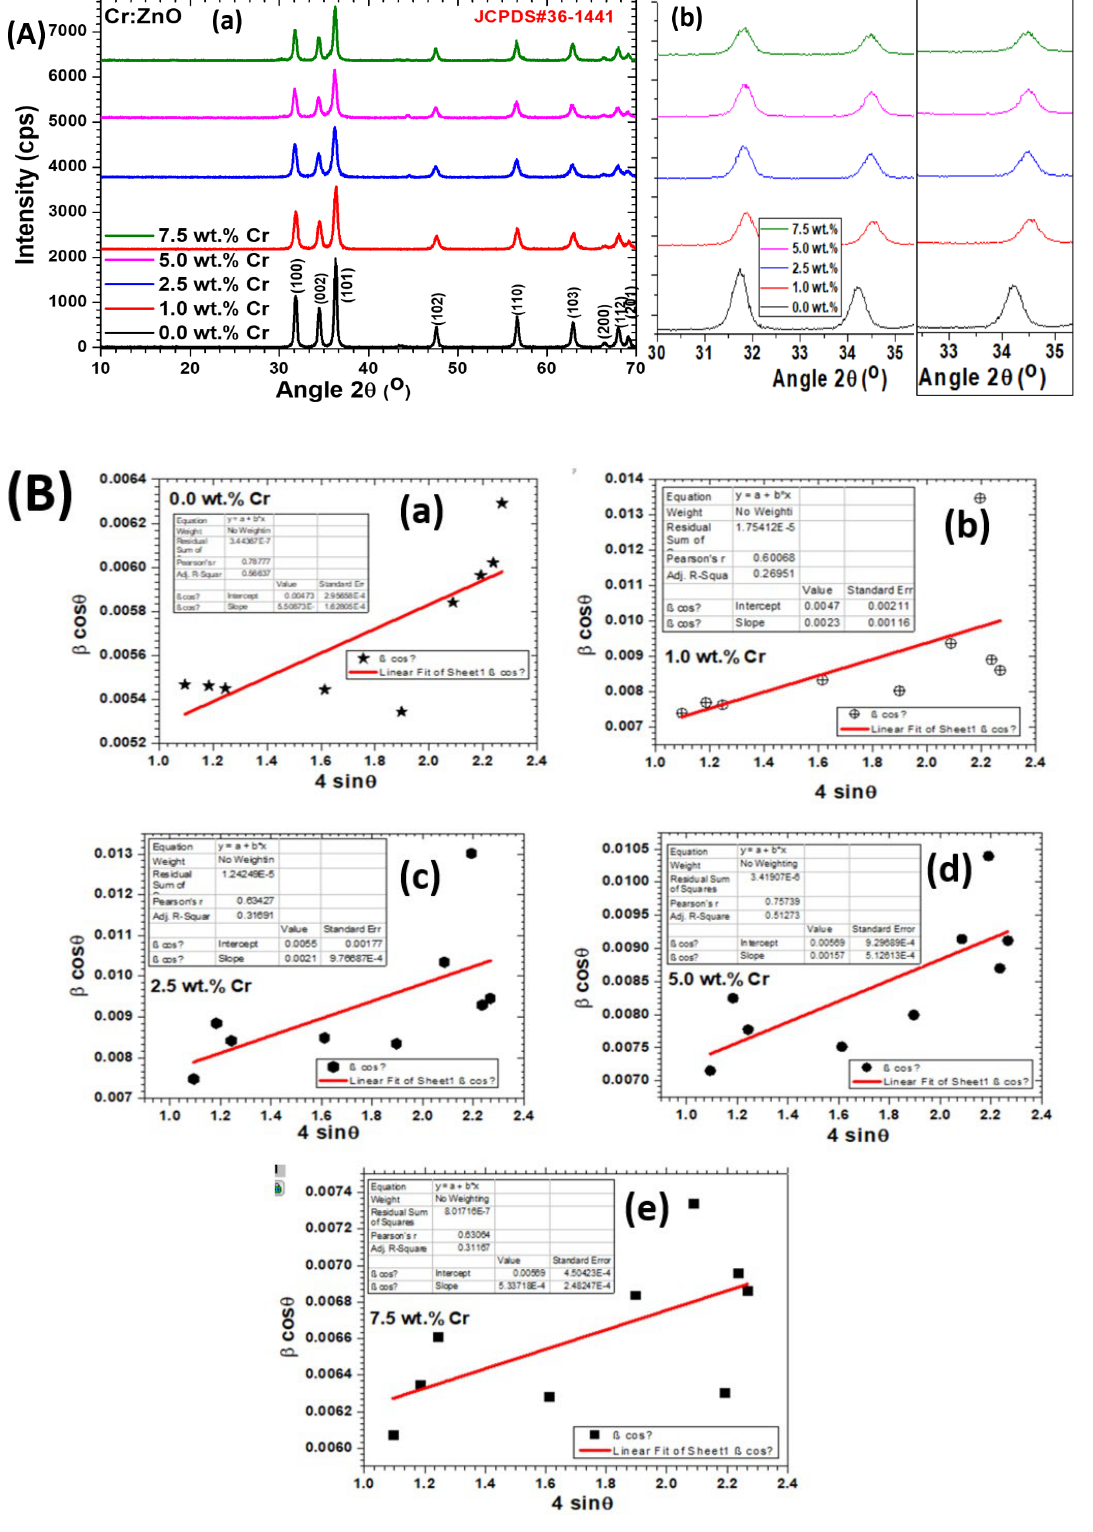
Figure 1. ( A ) ( a ) XRD patterns and ( b ) close view of the peak shift for pure and Cr-doped ZnO NPs. ( B ) W-H plots for ( a ) pure and ( b – e ) Cr-doped ZnO NPs.